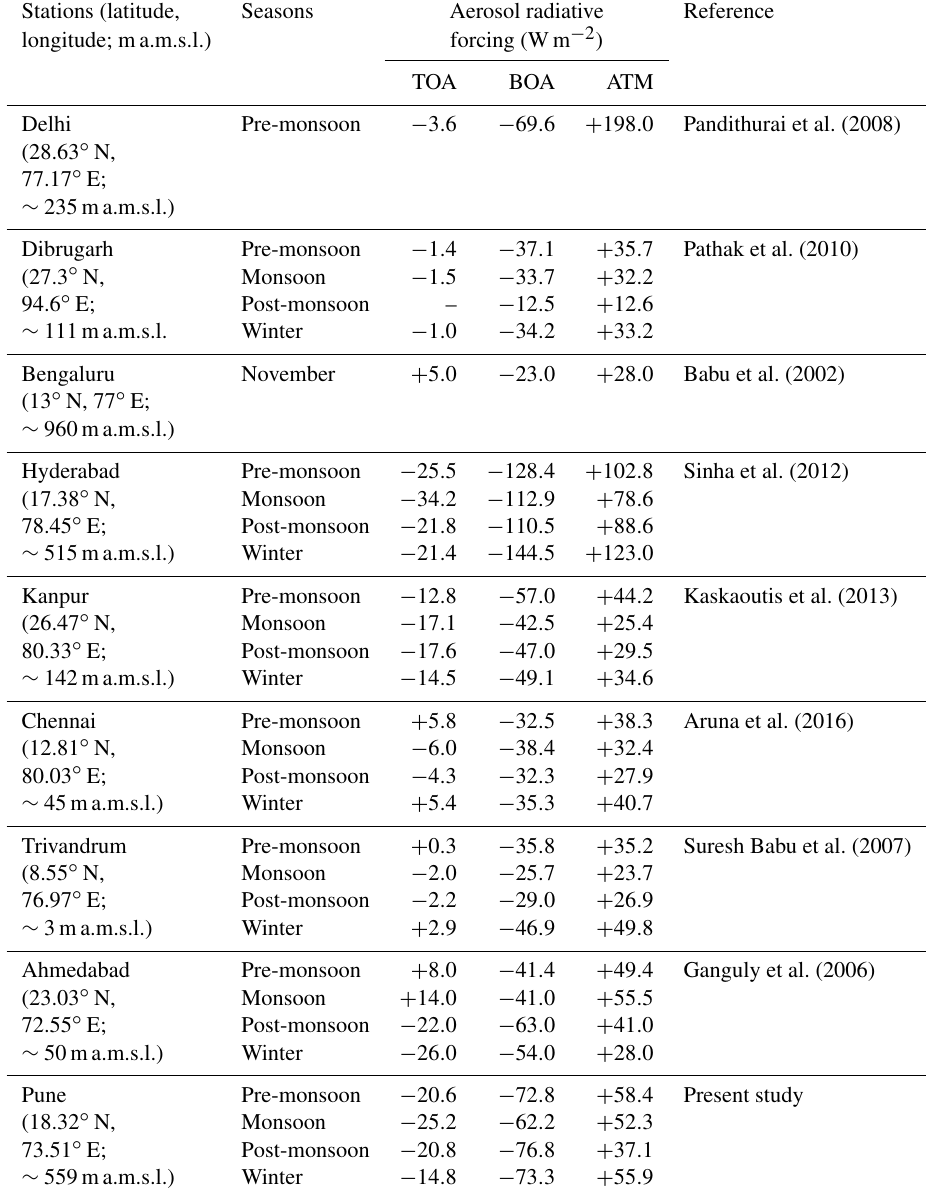
Table 3. Comparison of aerosol radiative forcing (Wm − 2 ) at different stations in India. Stations (latitude, Seasons Aerosol radiative Reference longitude; ma.m.s.l.) forcing (Wm − 2 ) TOA BOA ATM Delhi Pre-monsoon Pandithurai et al. (2008)